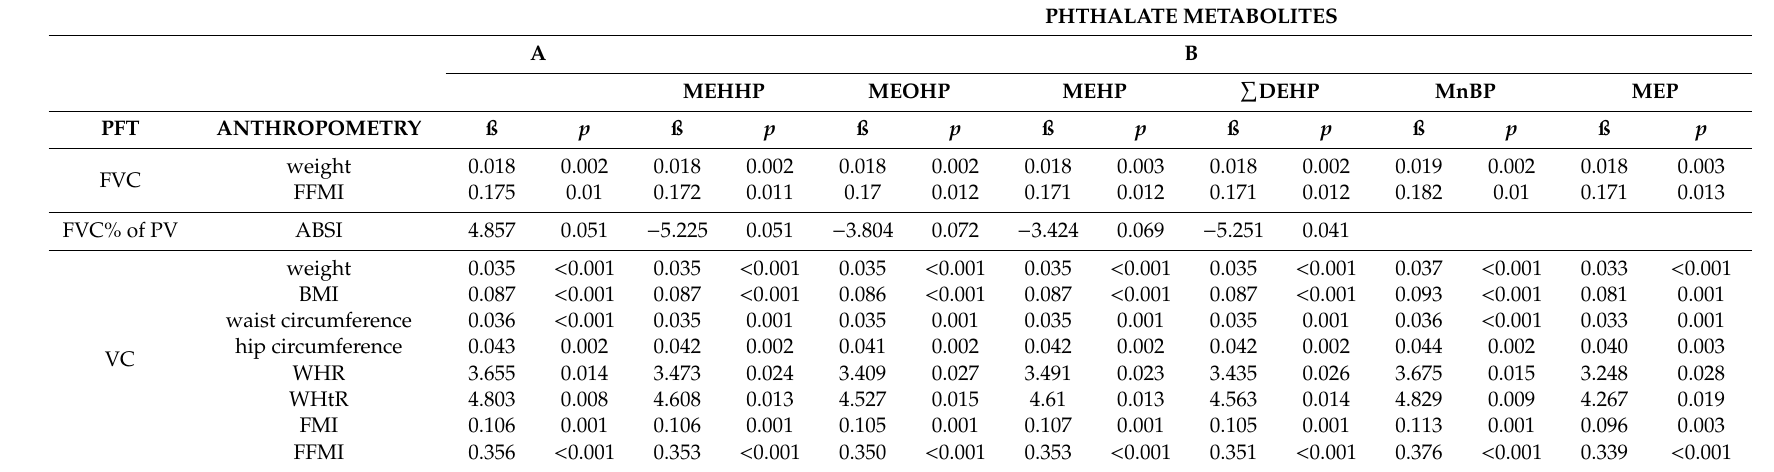
Table 8. A multivariate regression analysis between pulmonary functional test parameters and anthropometric parameters adjusted to occupational exposure to phthalates in